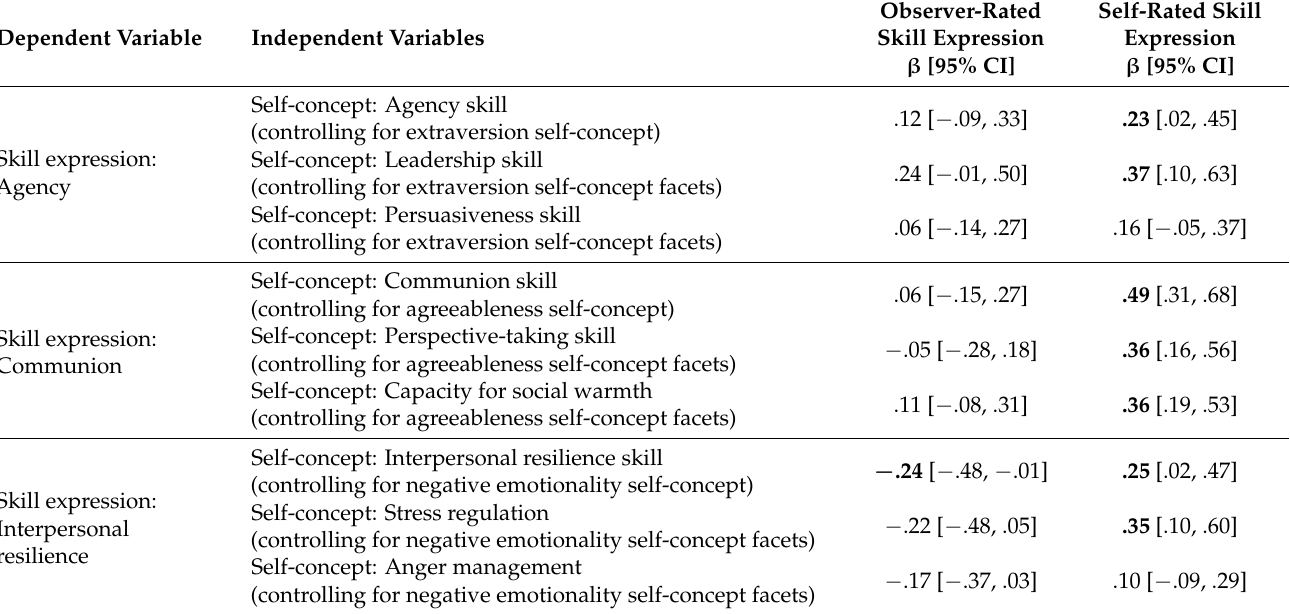
Table 6. Incremental Validity of Skill Self-Concepts in Predicting Skill Expression When Controlling for Corresponding Personality